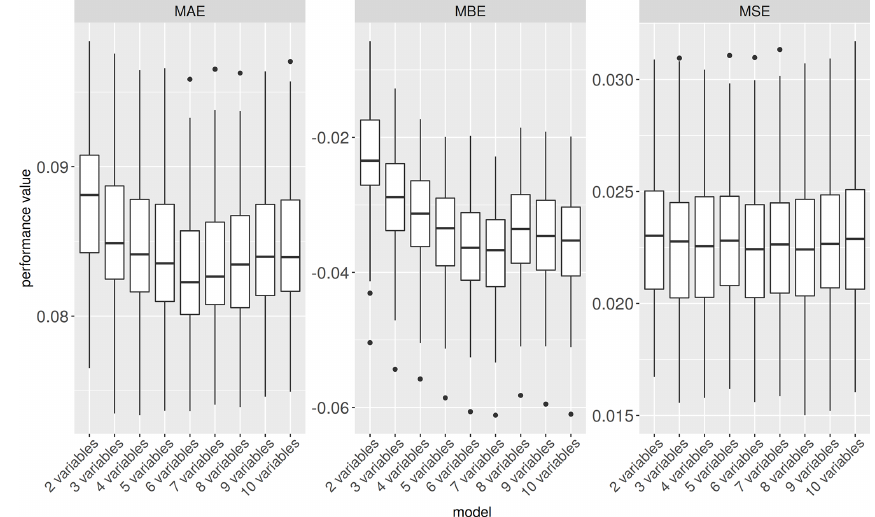
Figure 5. Predictive performance of models using an increasing number of variables in order of their importance. Smaller MAE and MSE values and MBE values close to 0 indicate better performance; cf. Eqs. (1)–(3). Table 4. Model performance metrics for models using an increasing number of variables arranged in the order of wst, PARatio, RadGyras, Area, LinSegInd, BoundRatio, Perimeter, DegrComp, FracDimInd and ShapeIndex. Best performance values and selected models are in bold. Model MAE MBE MSE QR HR